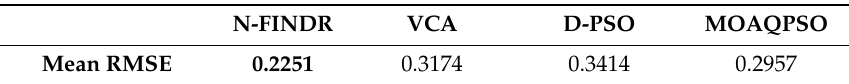
Table 3. Comparison between the Root-Mean-Square Errors (RMSEs) of N-FINDR, VCA, D-PSO, and MOAQPSO.